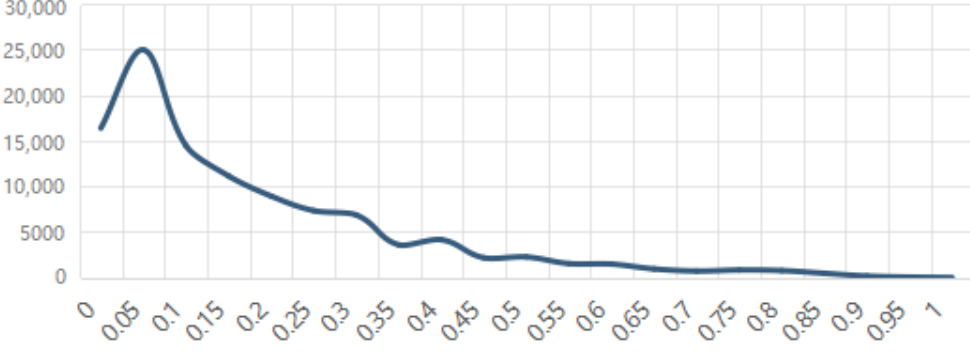
Figure 1. Score Distribution Returned by Botometer